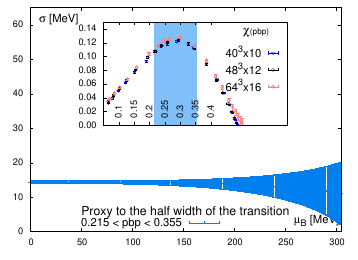
ψψ . The shaded (cid:31) (cid:30) ψψ ψψ / ∆ (cid:31) (cid:30) c ± (cid:31) (cid:30)